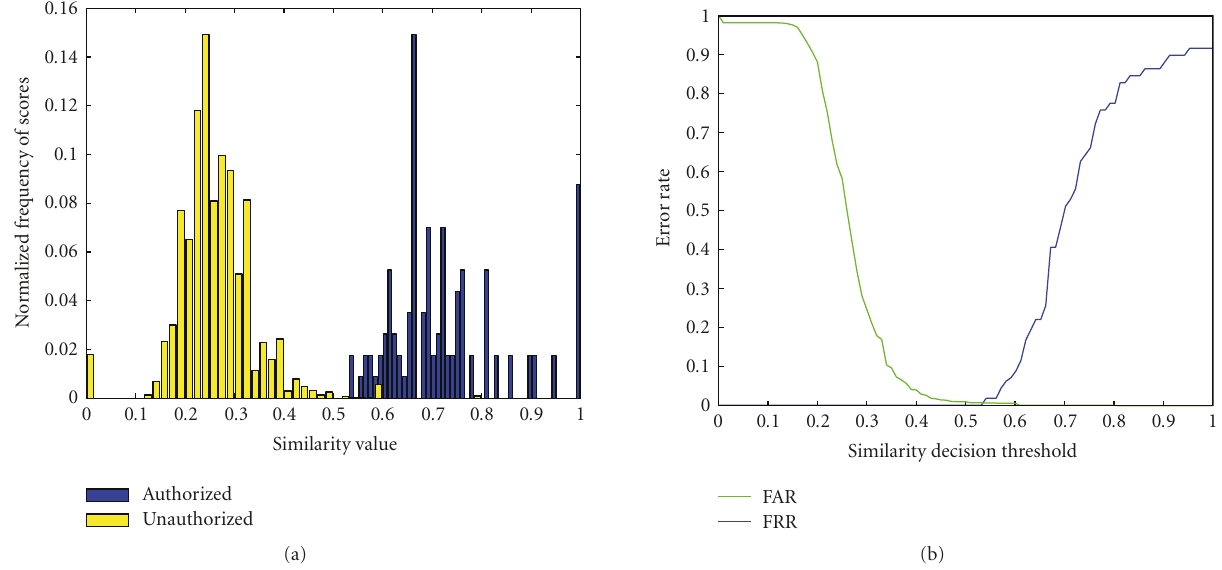
Figure 12: (a) Similarity values distribution for authorised and unauthorised accesses using f = min( M , N ) as normalisation function for the metric. (b) False accept rate (FAR) and false rejection rate (FRR) for the same